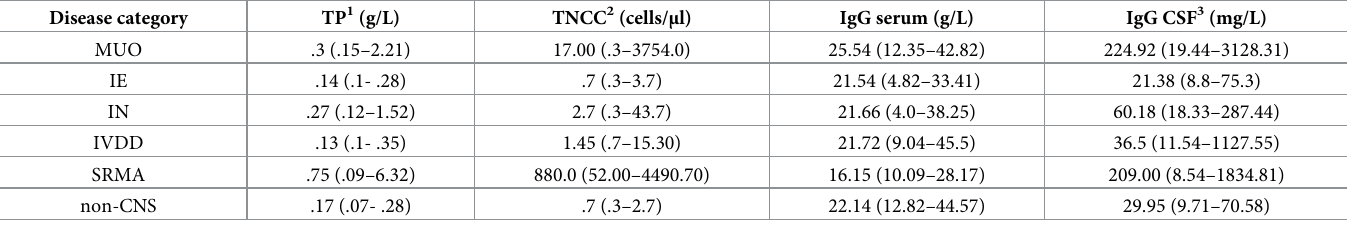
Table 3. Median values as well as range (in brackets) of total protein (TP), total nucleated cell count (TNCC), IgG in serum and CSF per disease category.